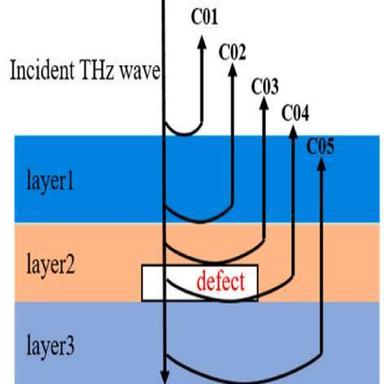
Schematic diagram of the THz NDT scenario for the multilayered GFRP composite in the numerical simulation study.